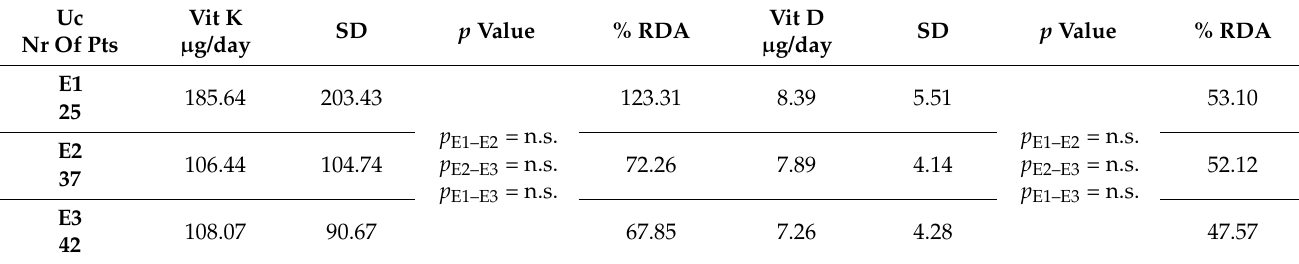
Table 5. Vitamin K and D intake, in Ulcerative Colitis, in relation to disease